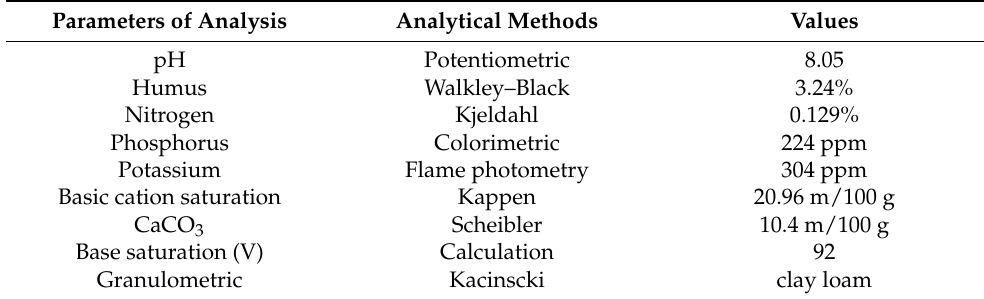
Table 6. Soil characteristics of the experimental plot.